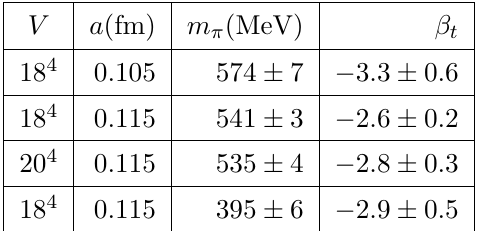
Table 6 . The tensor polarizability (cid:12) t of the (cid:26) 0 meson is shown in the last column for the lattice volume V , the lattice spacing a and the pion mass m (cid:25) .